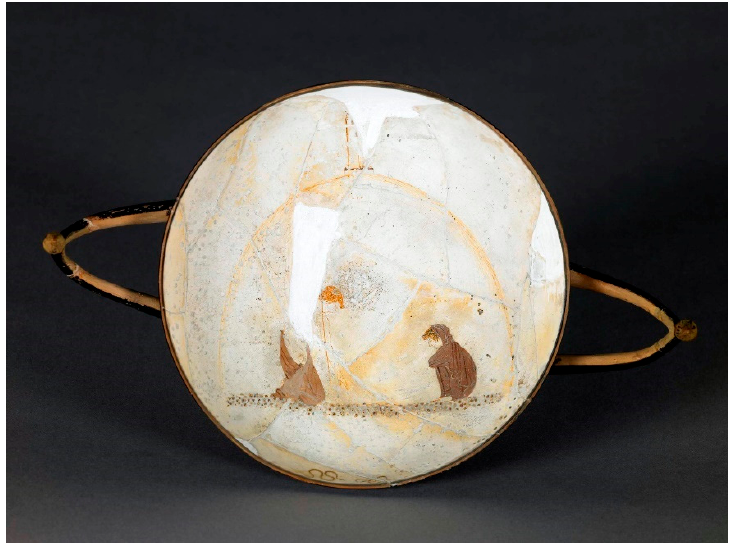
Figure 11. Glaukos and Polyeidos in the Tomb (BM reg. no. 1892,0718.2); white-ground kylix; signed by Sotades; Athens; ca. 460–450 BCE . [Image courtesy of the Trustees of the British Museum, London].